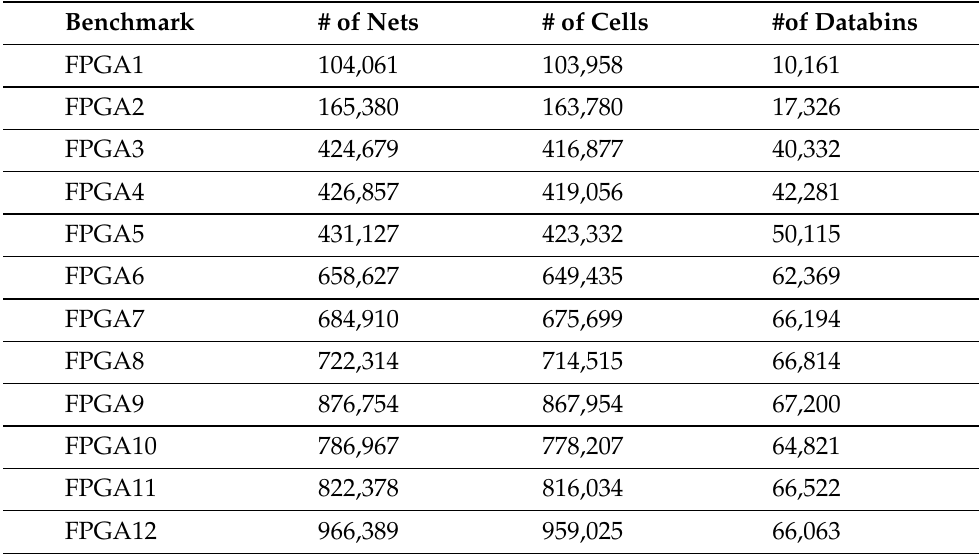
Table 4. Statistics of the testing data. The examples FPGA1 to FPGA12 are from the ISPD 2016 placement contest